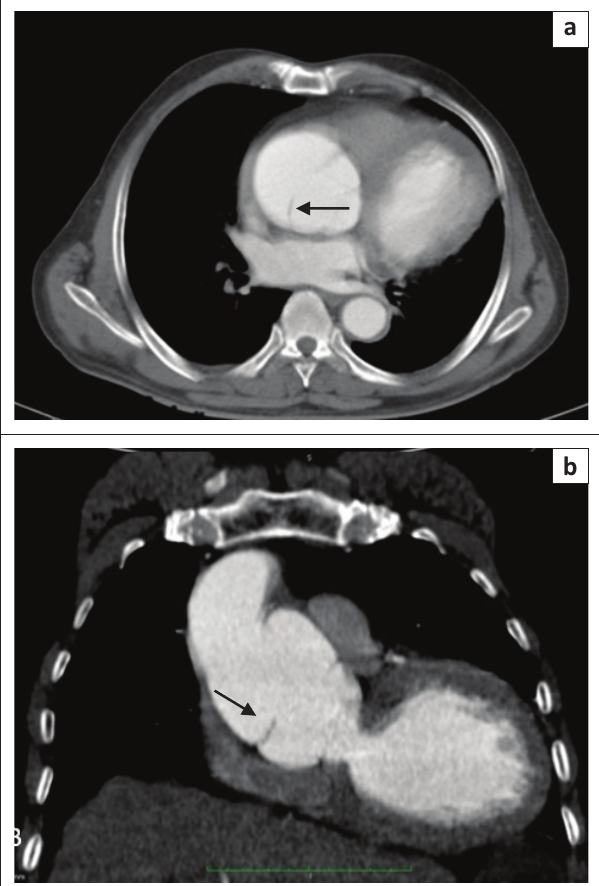
FIGURE 5: Type A chronic dissection. Contrast-enhanced axial (a) and coronal (b) computed tomography scan showing an ascending aortic aneurysm with chronic dissection. A thin linear low attenuation discontinuous dissection flap (arrow) is seen within the